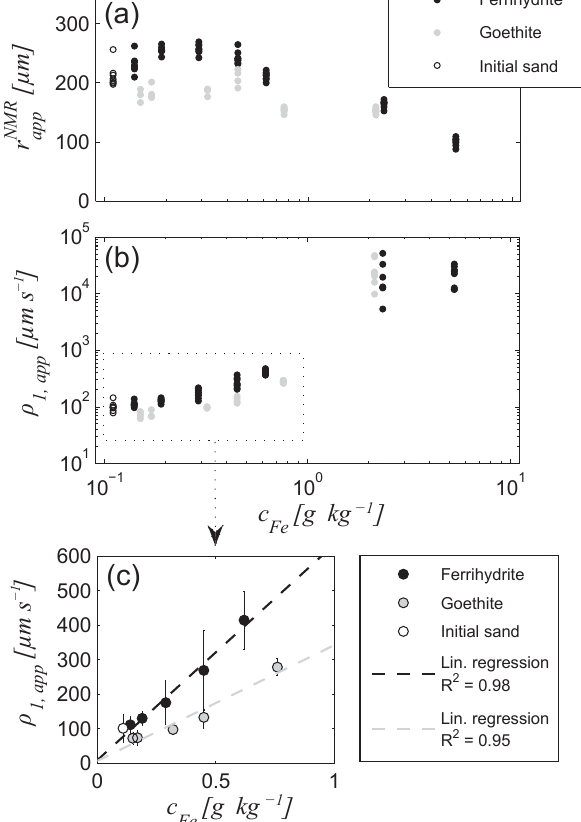
and the corresponding app